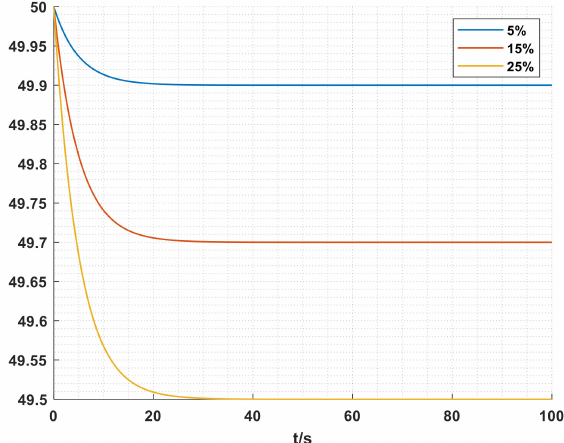
Figure 10. Frequency variation caused by different penetration rates of wind turbine and PV.